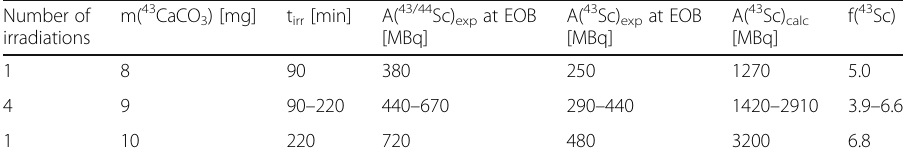
Table 2 Comparison of the measured total activities A( 43/44 Sc) exp , the experimental 43 Sc activities A( 43 Sc) exp as well as the calculated activities A( 43 Sc) calc , obtained from proton irradiations of enriched 43 CaCO 3 targets, measured at EOB Number of